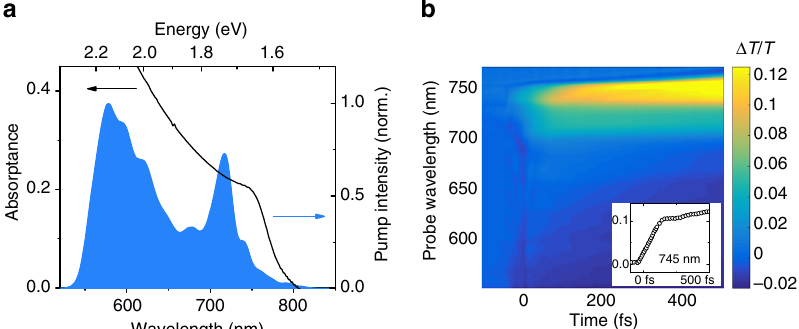
Fig. 1 Pump – probe spectroscopy of lead iodide perovskite. a Absorption spectrum of lead iodide perovskite and broadband laser spectrum used for the degenerate pump – probe and 2D electronic spectroscopy (2DES) experiments. The pump spectrum overlaps with the free band continuum as well as the excitonic transition of perovskite. b Pump – probe spectroscopy of perovskite: Δ T / T spectrum as a function of probe wavelength and pump – probe delay (excitation density: 2 × 10 18 cm − 3 ). The broadband nature of the short pump pulses makes the observation of a non-thermalized distribution and thermalization dif fi cult in pump – probe experiments. Inset: Pump – probe dynamics at 745nm probe wavelength. The signal rises over two distinct